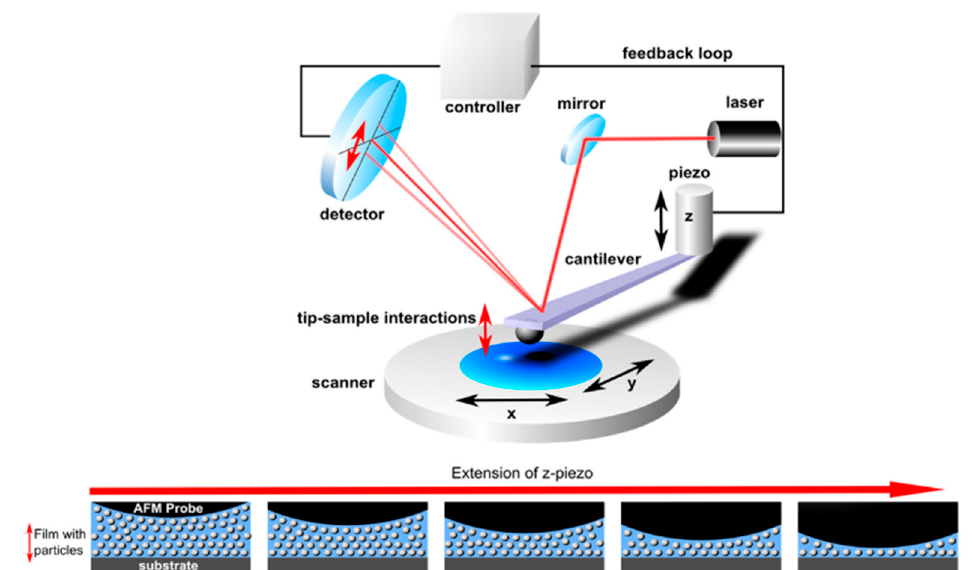
Figure 8. Top: colloidal probe AFM with x-, y-, and z-piezo scanners. Bottom: structuring of nanoparticles between the colloidal probe and the silicon wafer, and layer-wise expulsion due to extension of the z-piezo scanner leading to an approach of the two outer surfaces. Reprinted with permission from [48]. Copyright 2015 Elsevier.